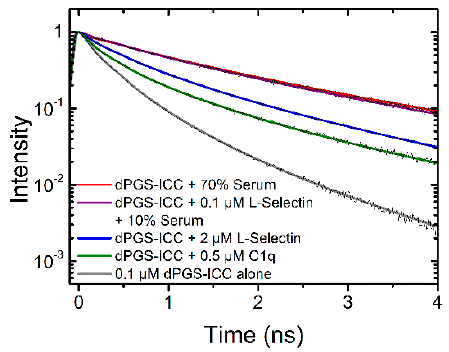
Figure 10. Lifetime signatures of dPGS-ICC with different proteins and human serum.